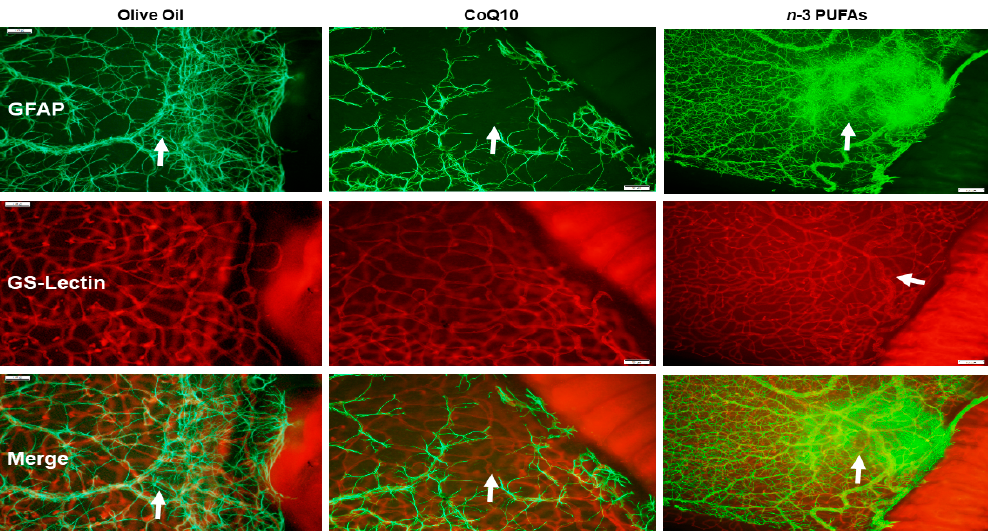
Figure 6. Representative images of retinal flatmounts from 21-day-old rat exposed to 50/12% O 2 IH. Astrocytes and Müller cells were stained for GFAP immunoreactivity (green), and retinal vasculature was stained with isolectin B4, which is a biomarker for endothelial cells (red). Merged images are presented in the bottom panel. Animals were supplemented with olive oil ( left panels ), CoQ10 ( middle panels ), or n -3 PUFAs ( right panels ). Images are 10× magnification and the scale bar is 100 µM.